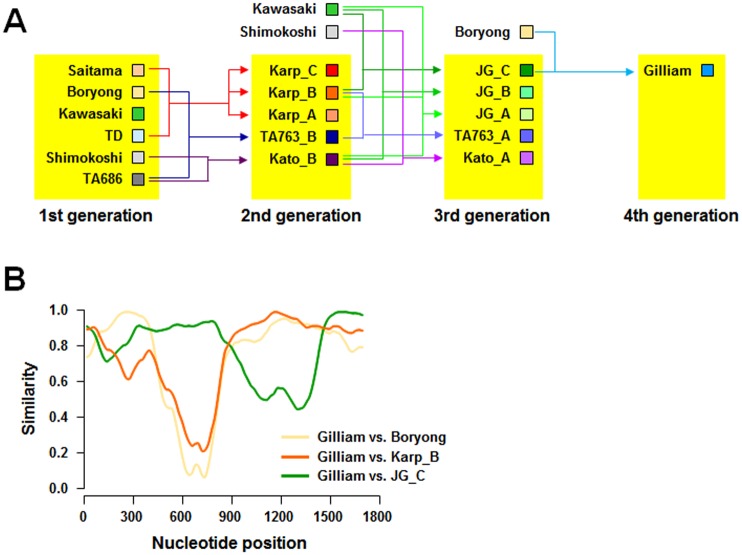
Hierarchical relationship of 17 proto-genotype sequences.A. Based on the recombination events and the parental origins of the tsa56 sequences shown in Fig 4, the hierarchical relationship of 17 genotypes was estimated and is presented as sequential generations. B. Recombination events in Gilliam genotype sequence, the last generation in A, were analyzed by similarity plot on the basis of pairwise comparison with Boryong, Karp_B, and JG_C genotypes as parental sequences (scanned with a window size 200 and step size 20 nt).